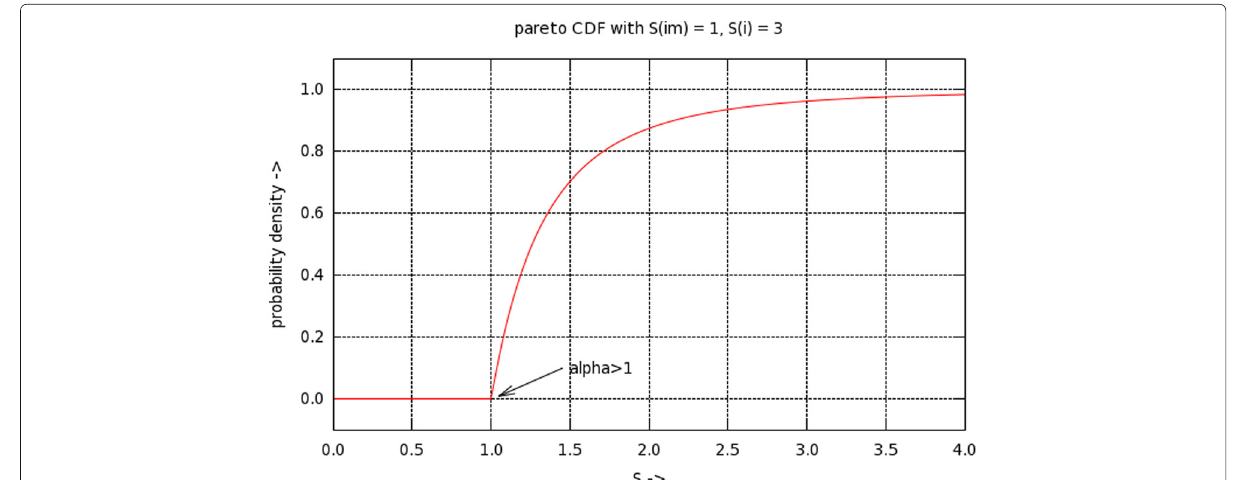
Fig. 9 CDF with S im = 1 and S i =